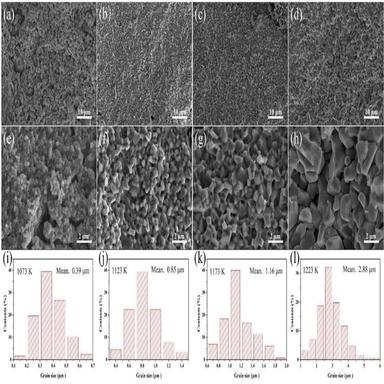
SEM cross section and grain size distribution of the pebbles sintered in air at: (a, e, i) 1073 K, (b, f, j) 1123 K, (c, g, k) 1173 K, (d, h, l) 1223 K.